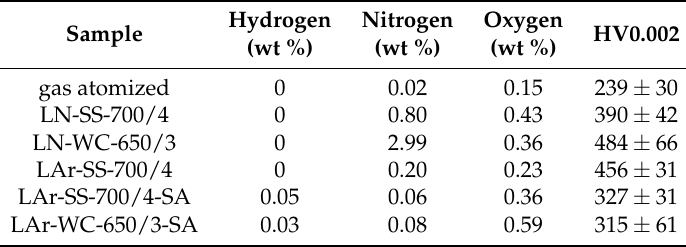
Contamination of cleaned powders by carrier gas hot extraction (CGHE) analysis (estimated relative error 5%) and Vickers microhardness (HV0.002) of powder particles measured on the